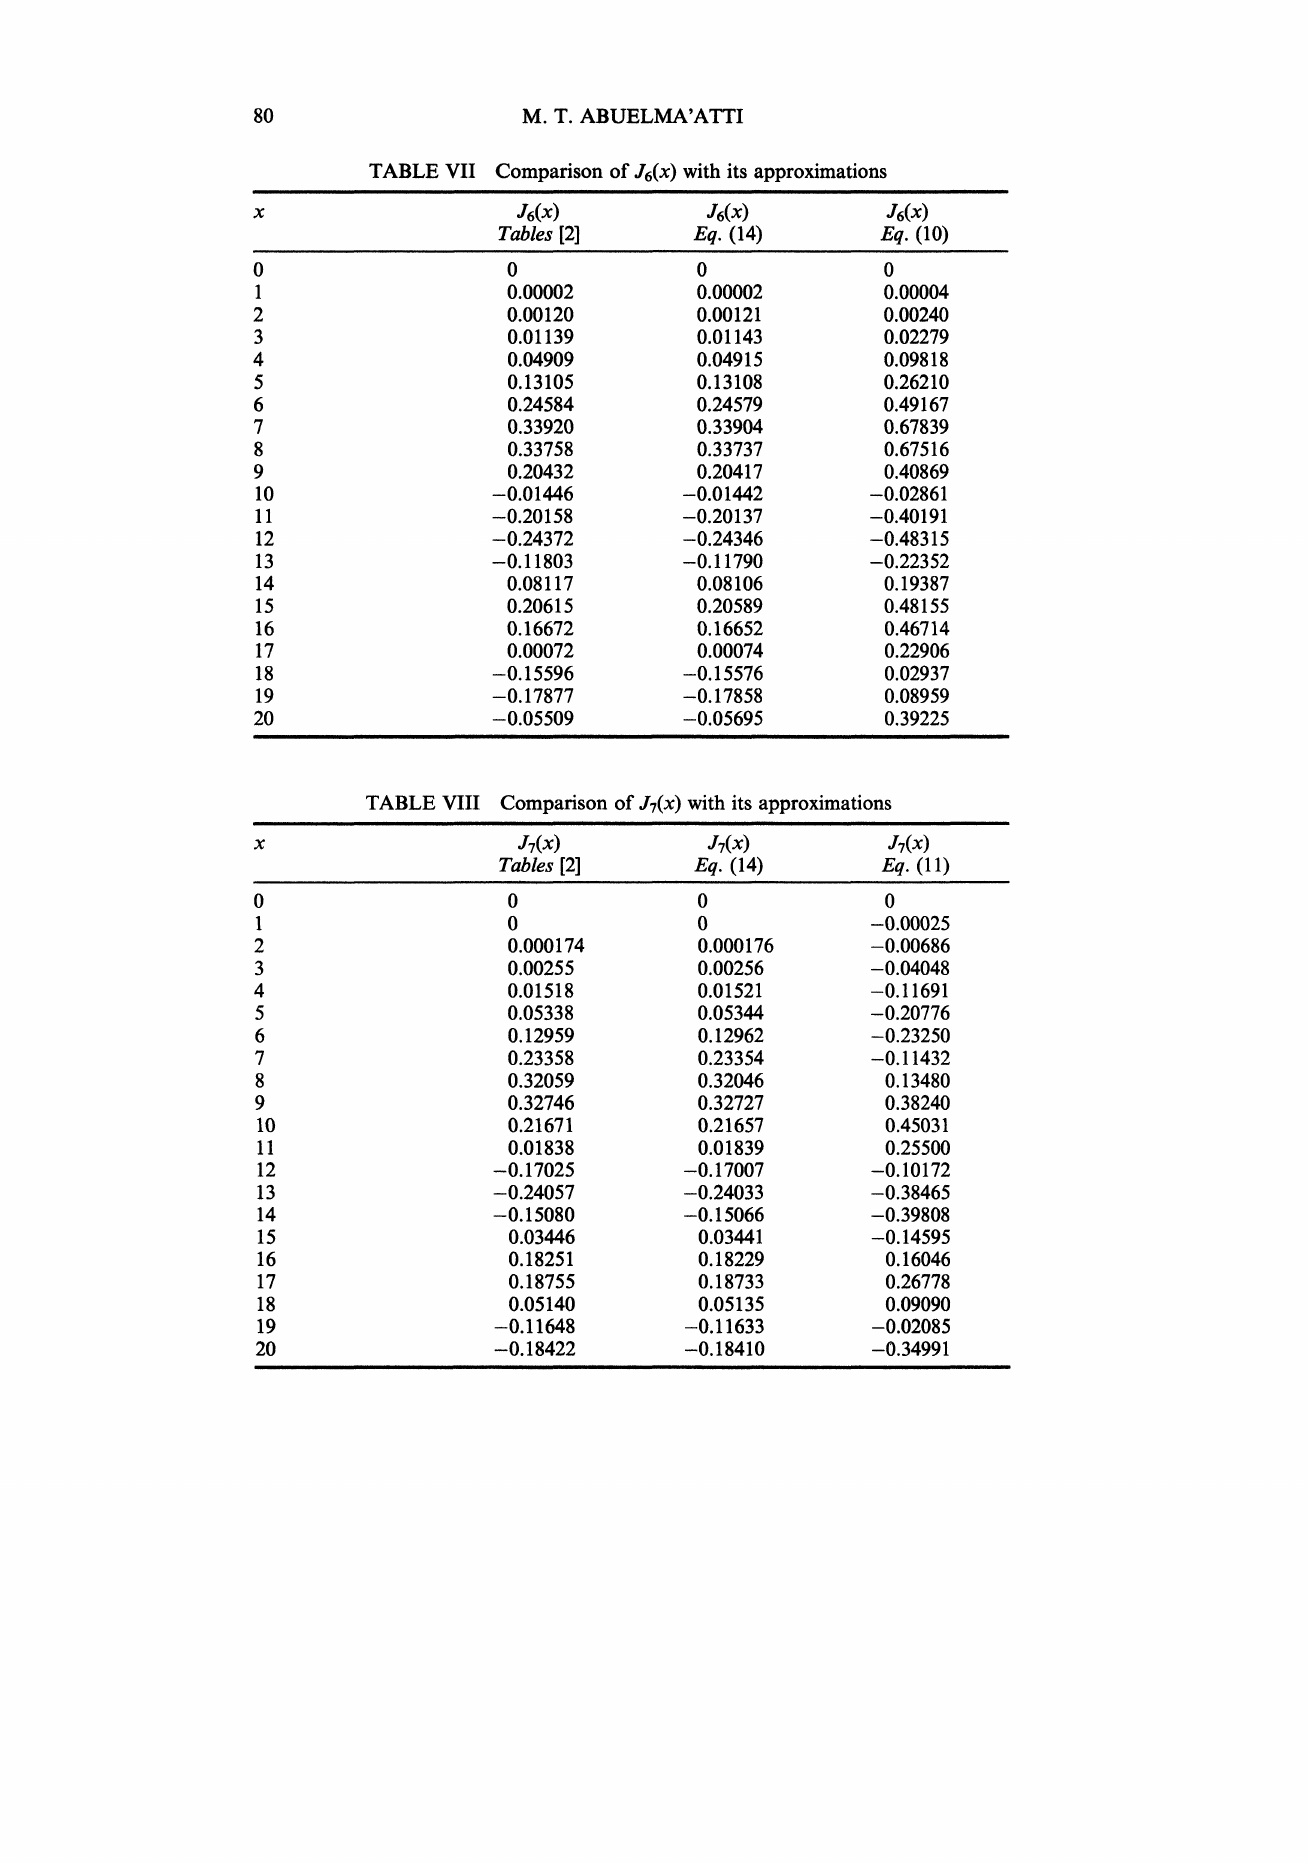
TABLE VIII Comparison of JT(x) with its